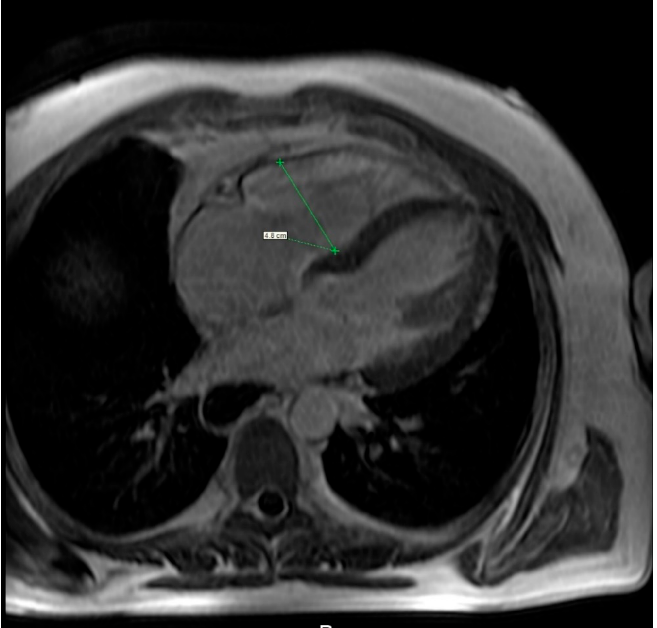
Figure 7. Cardiac magnetic resonance imaging of a 36-year-old woman with systemic sclerosis shows right ventricle dilation.